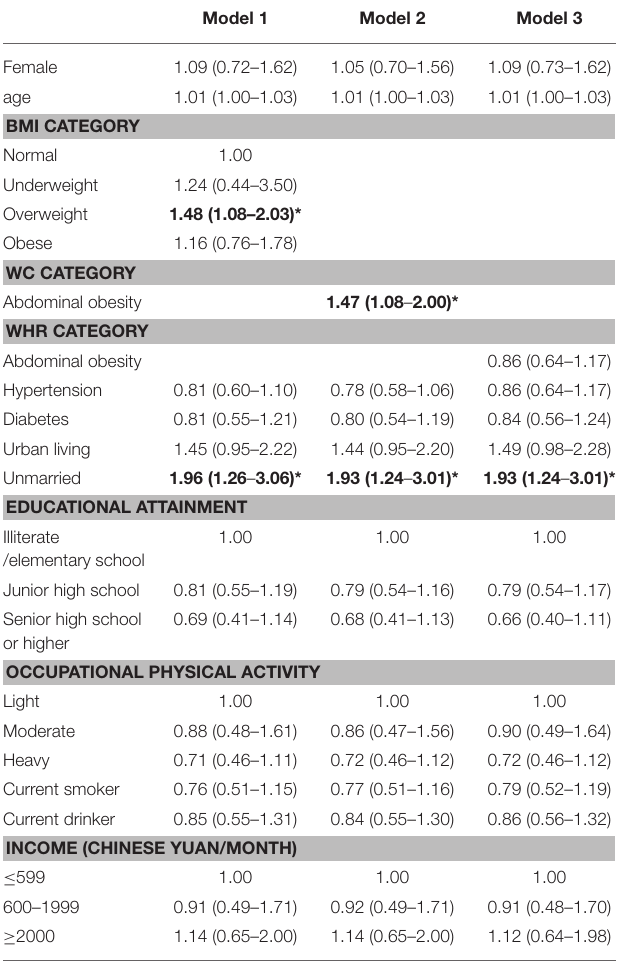
TABLE 3 | Sensitivity analyses for depression according to the Asian and WHO